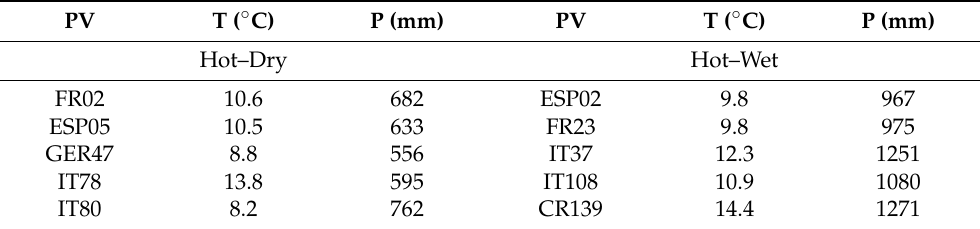
Table 3. Annual mean temperature (T) and annual precipitation sum (P) for original location of provenance groups used for simulation of growth, divided into contrasting climate groups. Full names of provenances are listed in Supplementary Table